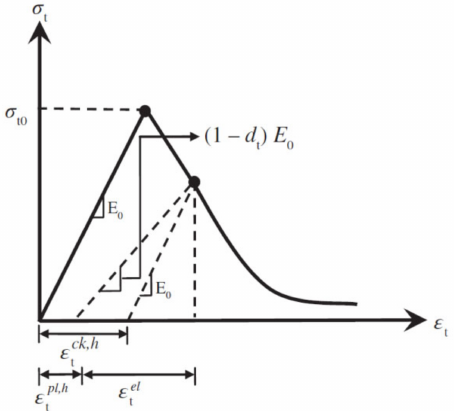
Figure 4. Concrete response to uniaxial tensile loading [30].